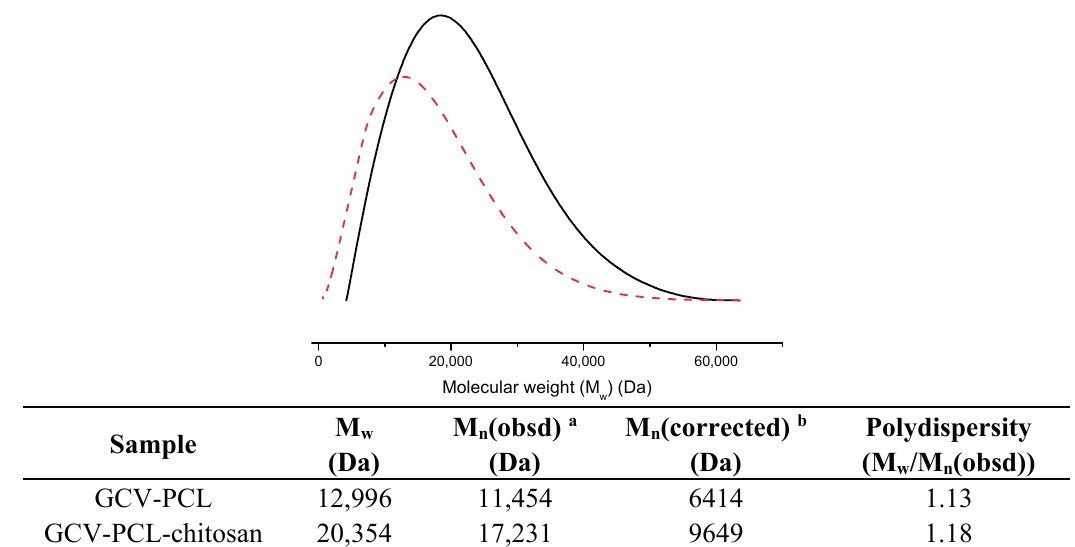
Figure 3. Characterization of molecular weight profiles of GCV-PCL ( - - - ) and GCV-PCL-chitosan ( ____ ) by GPC analysis.